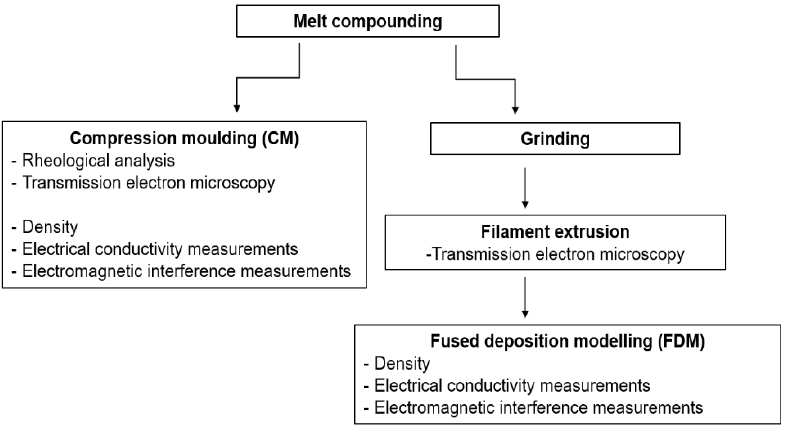
Figure 1 . Scheme of the manufacturing processes and characterization tests.